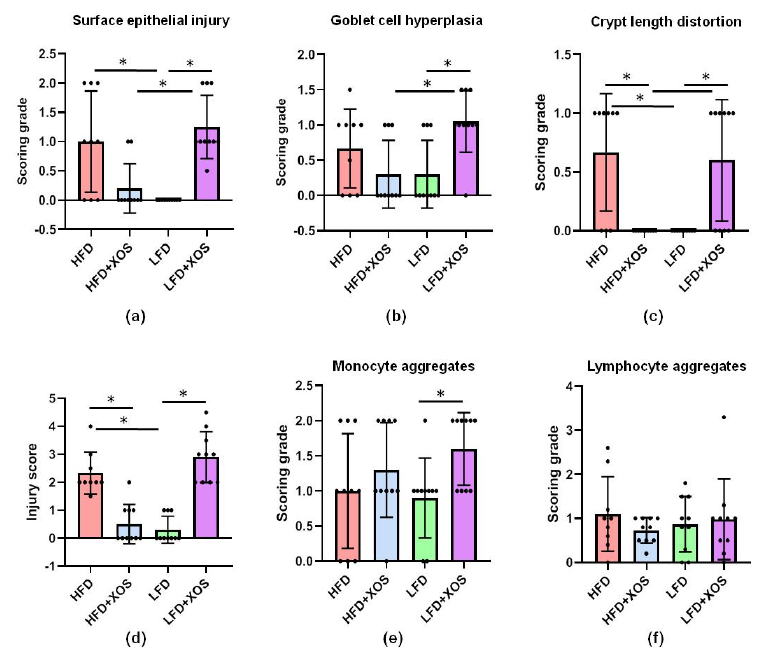
Figure 7. XOS improved the HFD-induced injury and inflammatory markers in the proximal colon. The histopathological examination detected an interactive effect of diet and XOS on the ( a ) surface epithelial injury; ( b ) Goblet cell hyperplasia; ( c ) crypt length distortion and; ( d ) injury score; ( e ) On the LFD, XOS increased monocyte aggregates; ( f ) The diets did not affect the lymphocyte aggregates. n = 8–10/diet group. The different data points are shown with black dots in all graphs. * denotes statistically significant difference between the groups in all graphs.